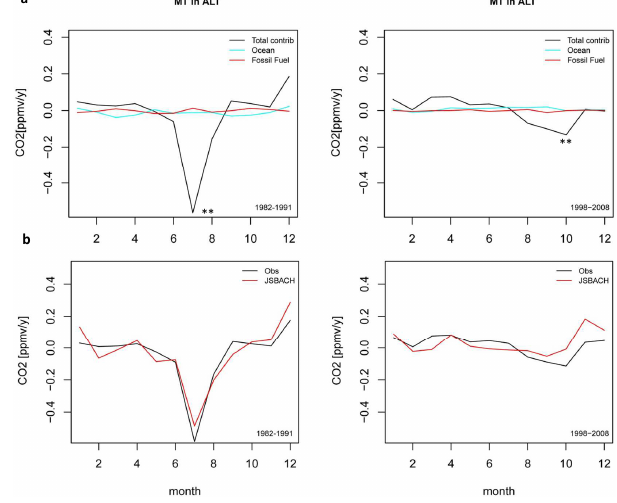
t−Onset Obs−Mod −180 −140 −100